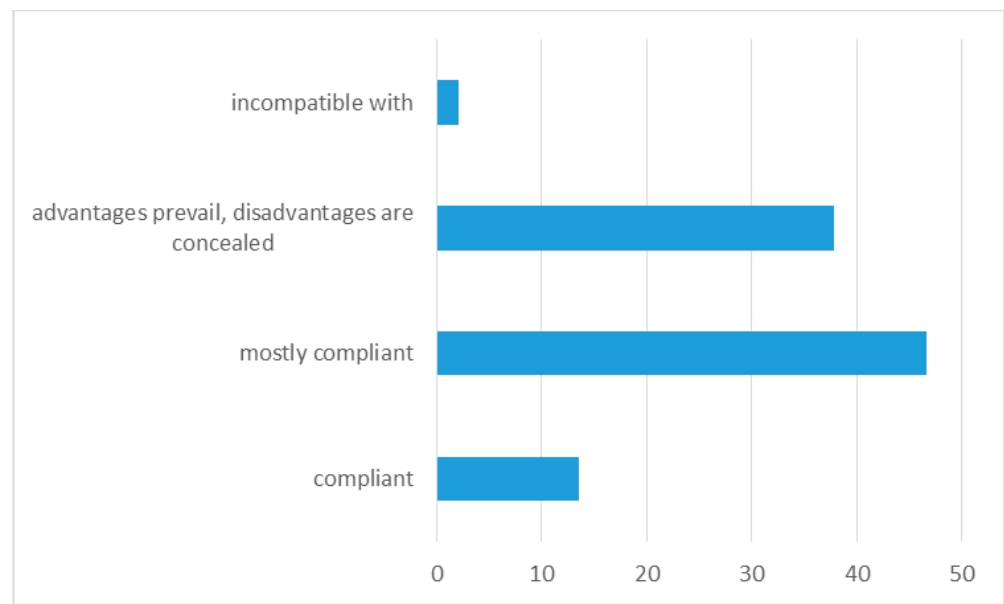
Figure 5. Conformity of the image of a tourist destination in social media with the reality [%]. Source: own work.